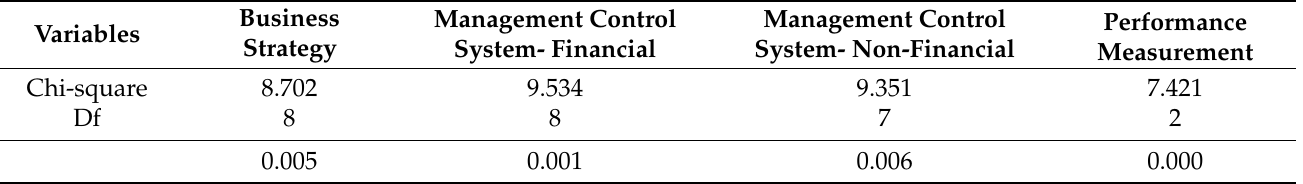
Table 13. Analysis of Kruskal–Wallis test in business strategy variables, management control system (financial-non-financial) and performance measurement.